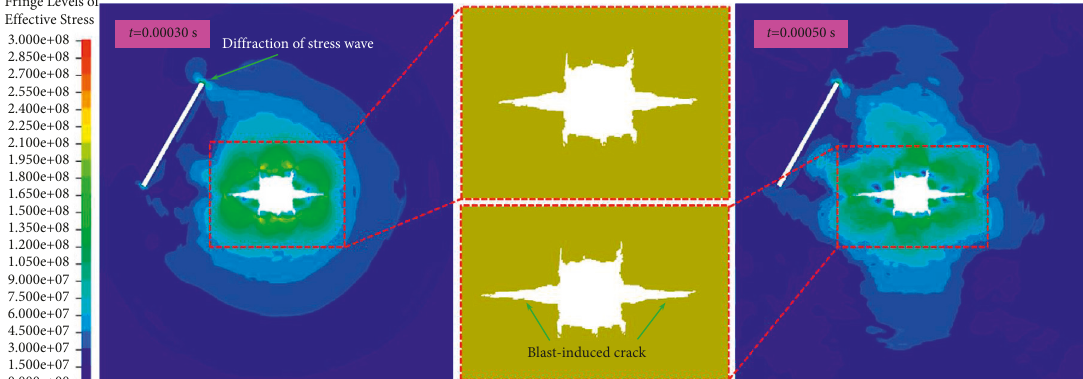
Figure 10: Pressure diagram of explosion stress wave transmission for case CN